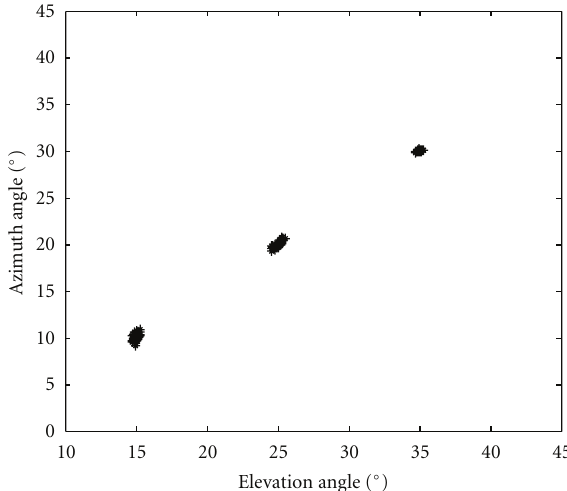
Figure 3: Elevation angle and azimuth angle scatter.